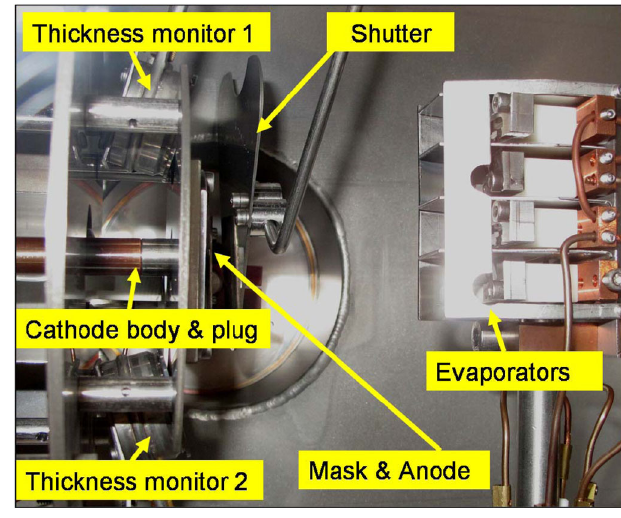
FIG. 2. (Color) Inside view of the preparation